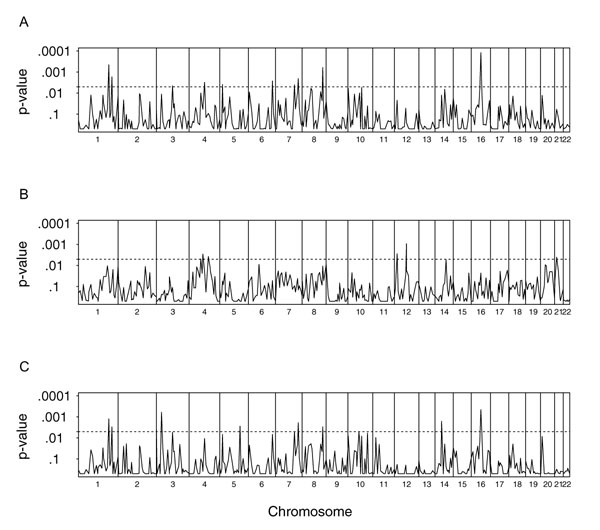
p-values for the three statistics throughout the genome Bivariate score statistic (A), univariate score statistic for adjusted cholesterol level (B), and univariate score statistic for adjusted triglyceride level (C).